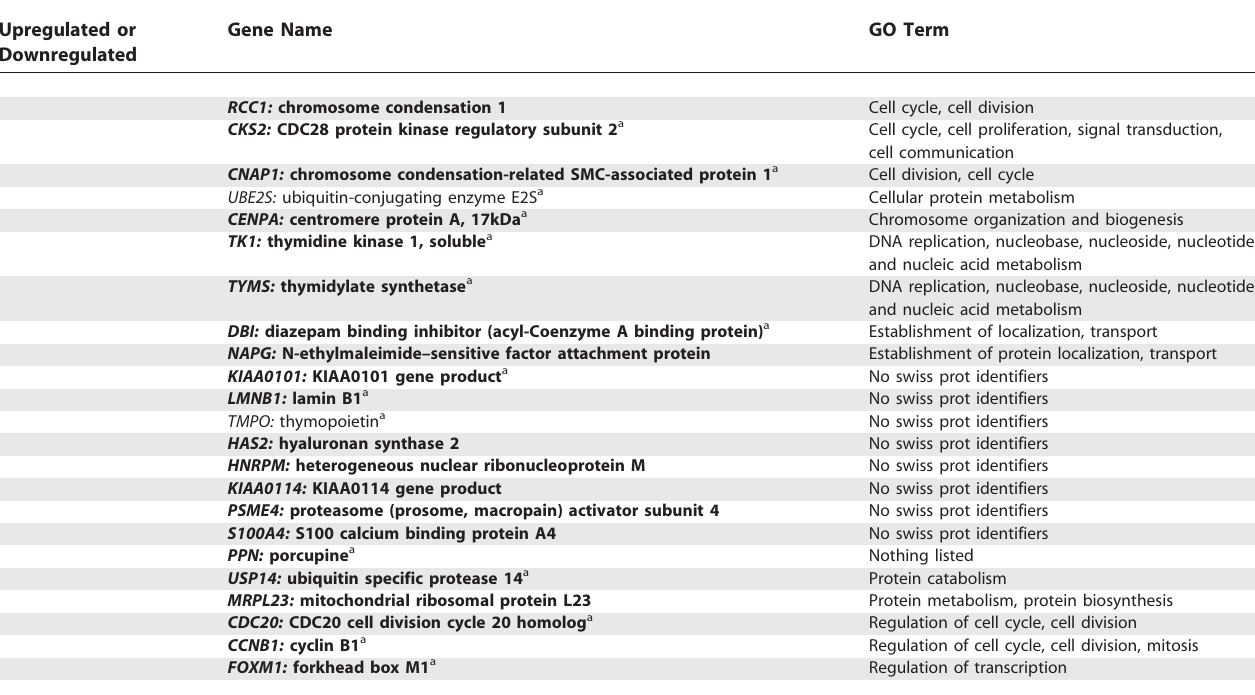
(Figure 9A) and myosin heavy-chain expression (Figure 9D), whereas fibroblasts that were made quiescent for 4 d by either serum withdrawal (Figure 9A and 9D) or contact inhibition (Figure 9B and 9E) were resistant to differentiation,